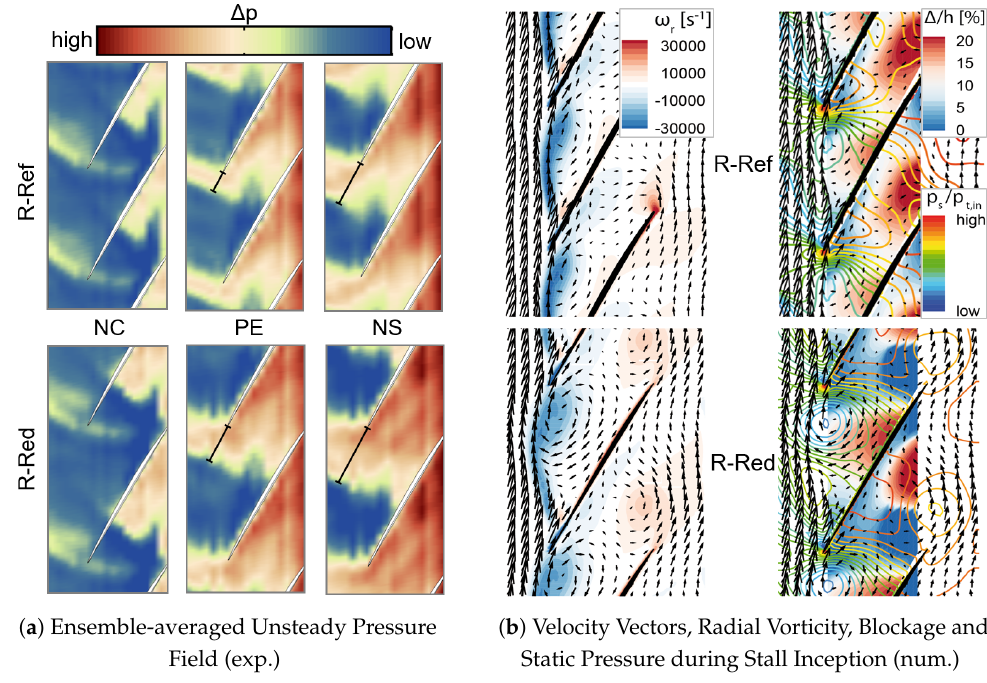
Figure 4. Unsteady Aerodynamics at Rotor Blade Tip for Design Speed Operating Conditions.